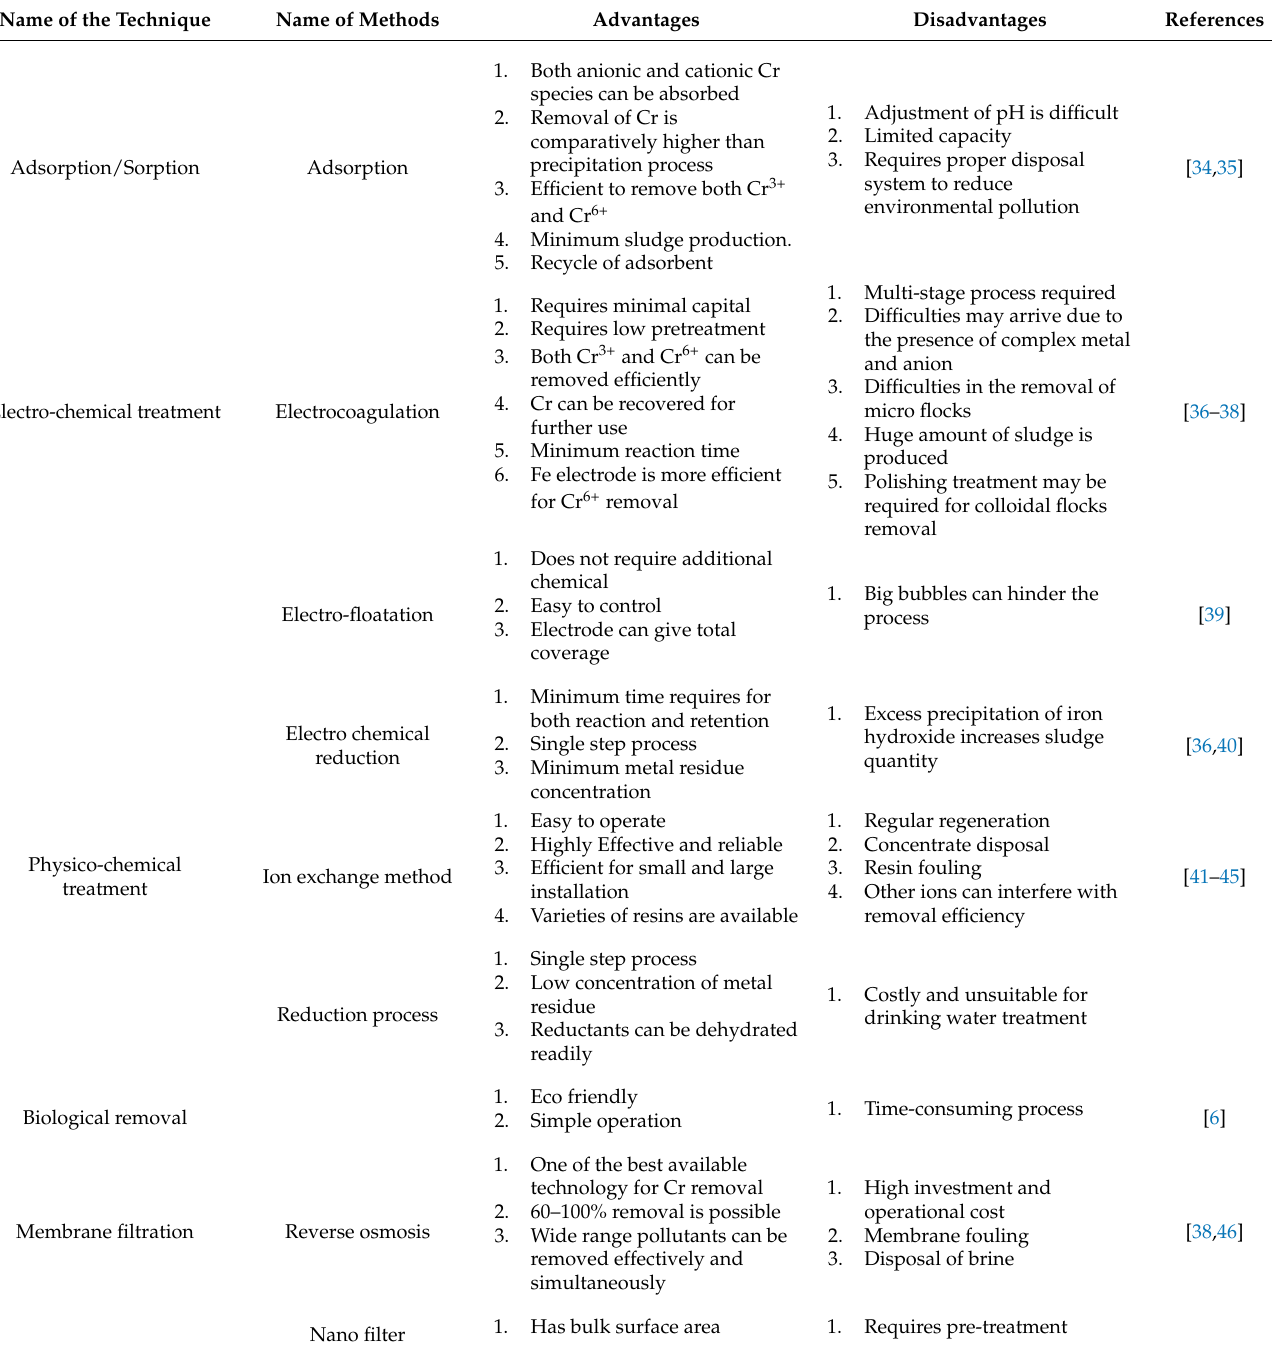
Table 1. Advantages and disadvantages of Cr removal